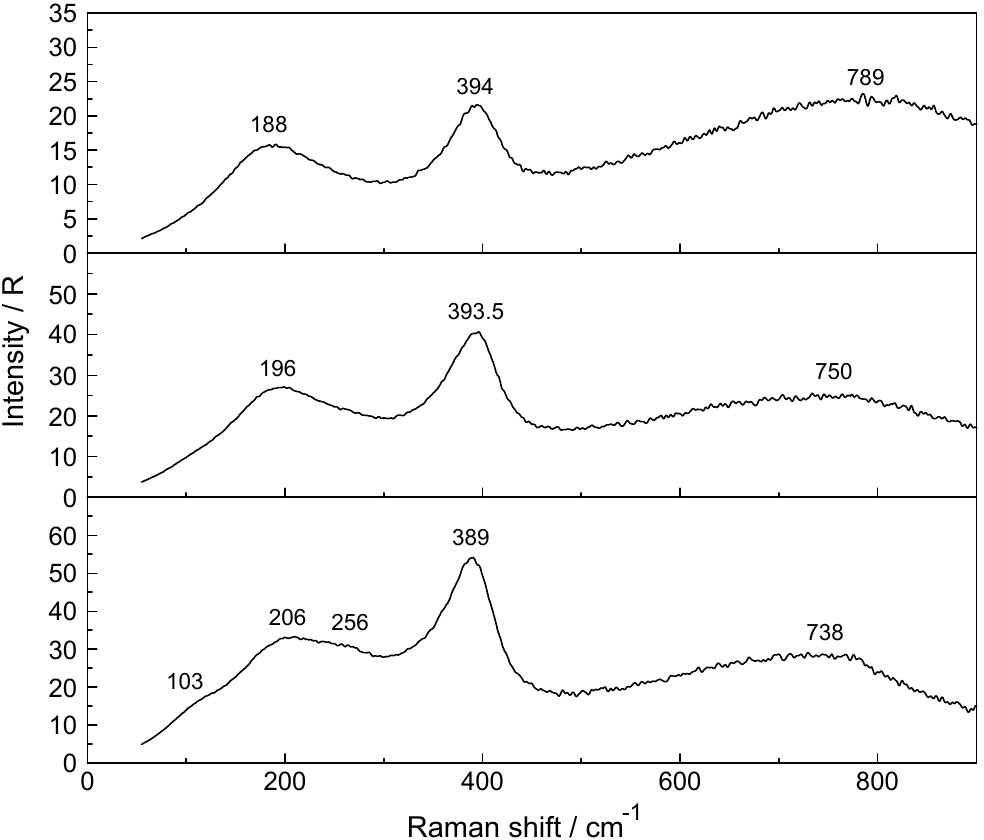
Figure 6. Isotropic Raman scattering profiles of YbCl 3 (aq) solutions from 55–900 cm − 1 . From bottom to top: 3.224 mol · L − 1 , 1.600 mol · L − 1 and 0.802 mol · L − 1 . The symmetric YbO 8 stretching mode appears at